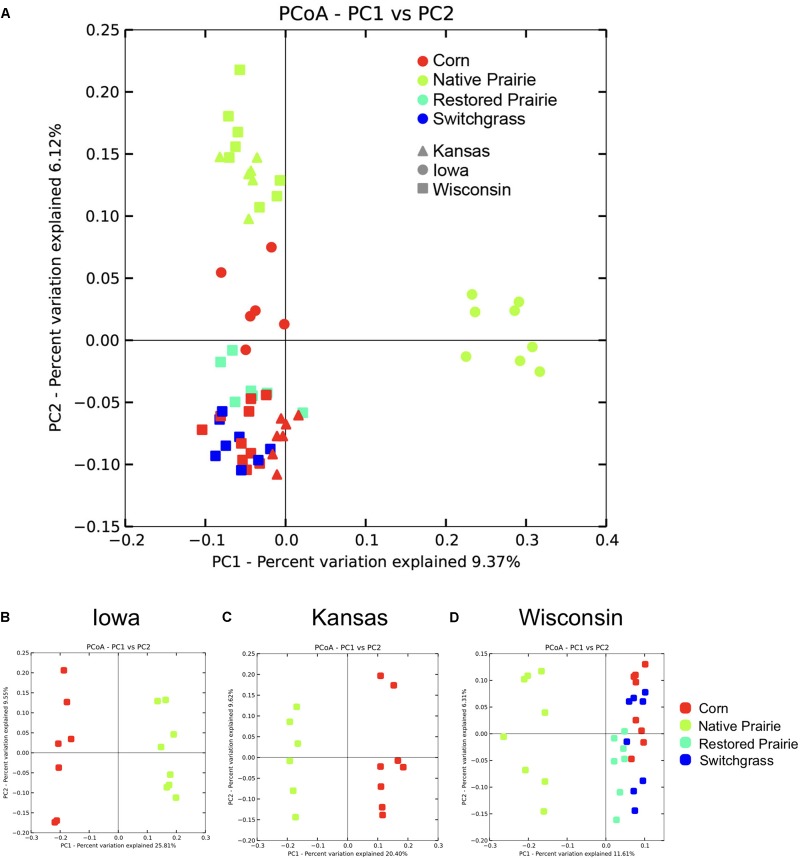
Visualization of beta-diversity reveals clustering by management type. Unweighted Unifrac distances were plotted using Principal Coordinate Analysis (PCoA) in QIIME. Each point represents a discrete sample. (A) PCoA plots of all sites and samples. (B–D) PCoA plots by state.